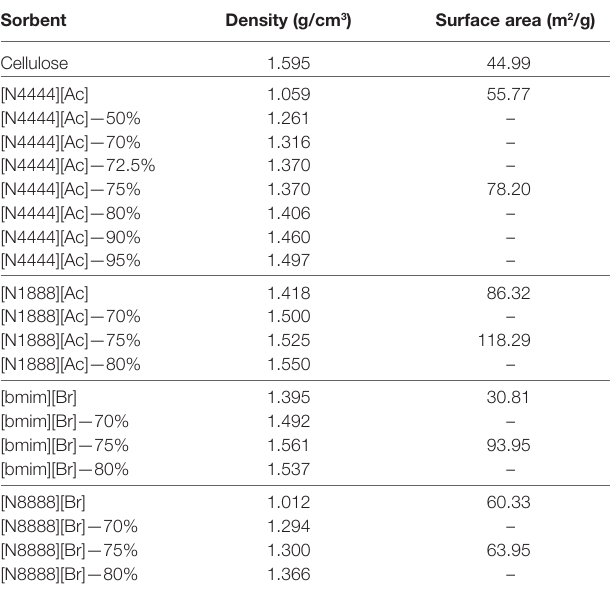
Table 2 | Selected supported and unsupported sorbent physical properties.